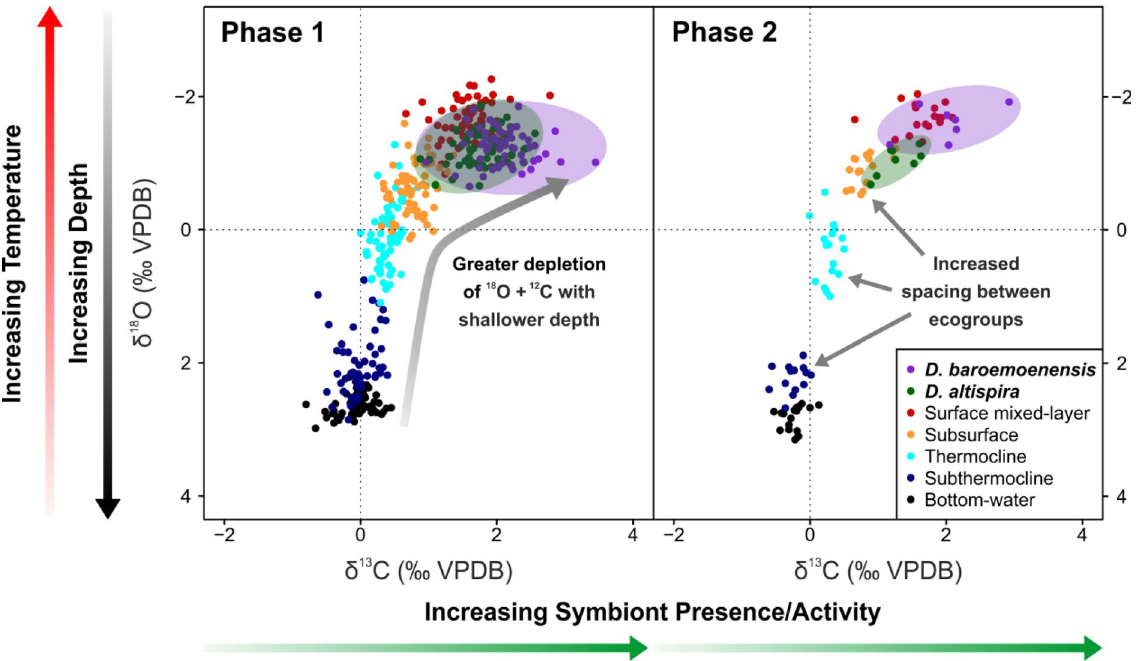
Figure 3. δ 13 C and δ 18 O cross-plots through Phase 1 and Phase 2. Black = Bottom-water , dark blue = subthermocline, cyan = thermocline, orange = subsurface , red = surface mixed layer, green = D. altispira , purple = D. baroemoenensis. Dentoglobigerina measurements are single specimens, others are multiple specimens.